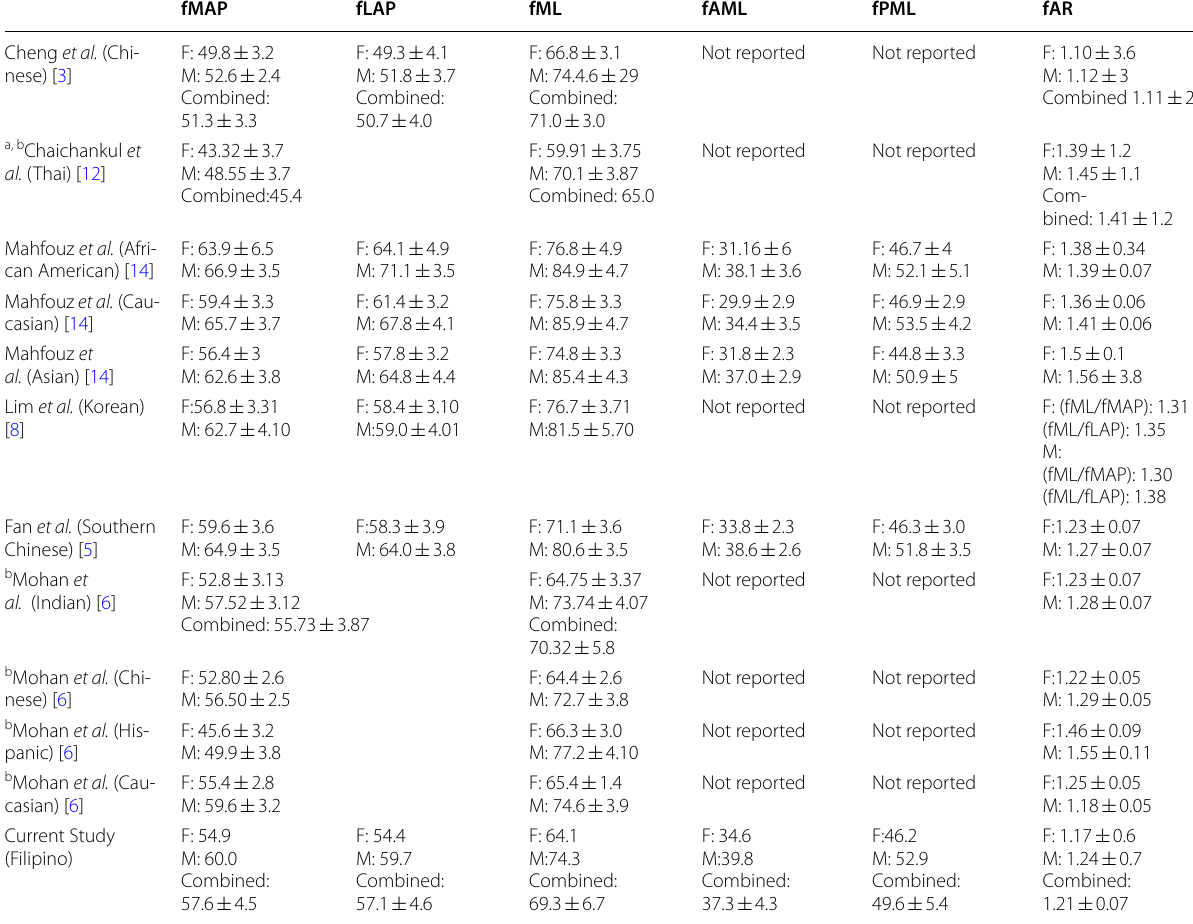
Table 8 Femoral morphometric parameters of different ethnicities (in